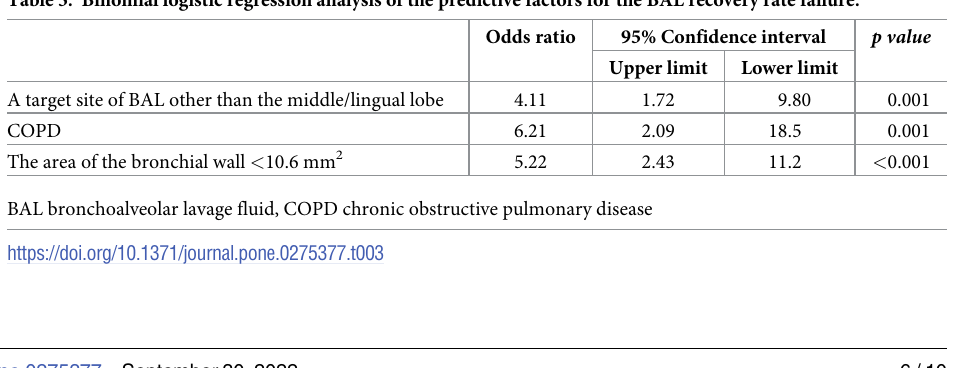
The common cause of BAL recovery rate failure is the collapse of the bronchus [4]. In the BAL procedure, fluid is suctioned back with a negative pressure connected to the working channel of the bronchoscope. The risk of bronchial collapse can increase due to loss of elastic recoil and increasing compliance with the bronchus [2, 4], which might be related to weakness of the bronchial wall [2, 4]. Therefore, the fact that a thin bronchial wall was related to a low BAL recovery rate is very important, and it is hypothesised that weakness of the bronchial wall might be related to BAL recovery failure. Weakness of the bronchial wall is also seen in older individuals [12]. Both atrophy of the bronchial glands and mucosa and reduced compliance in Table 3. Binomial logistic regression analysis of the predictive factors for the BAL recovery rate